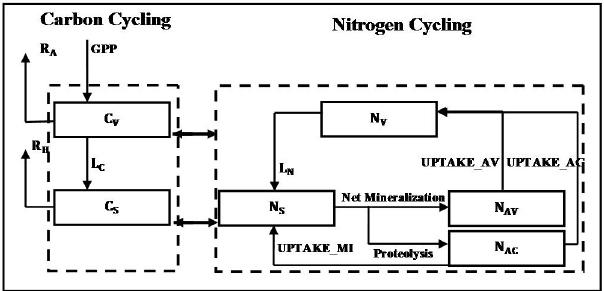
Fig. 1. ON-TEM model diagram: arrows are carbon or nitrogen fluxes; the boxes are state variables. The original TEM comprises five state variables: vegetation carbon (C V ), soil organic carbon (C S ), vegetation nitrogen (N V ), soil organic nitrogen (N S ) and soil inorganic nitrogen (N AV ). Here an amino acid pool (N AC ) is added. In ON-TEM, soil nitrogen has two pathways to be taken up by plants: (1) nitrogen is mineralized by soil microbes into inorganic , NO − or (2) nitrogen undergoes proteolysis into amino form, NH + 4 3 acids and is taken up by the plant.